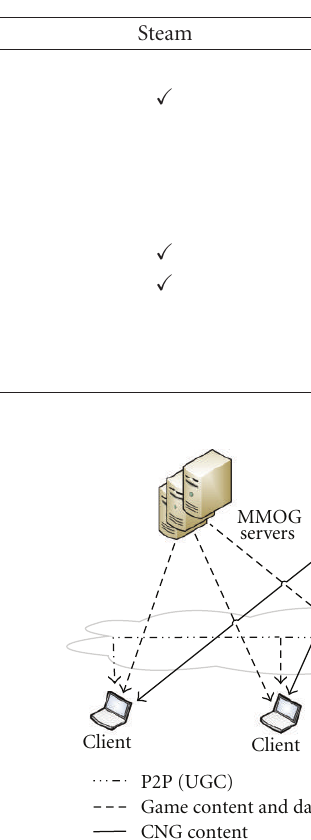
Table 1: CNG features support by the most significant similar systems (source: [7]).